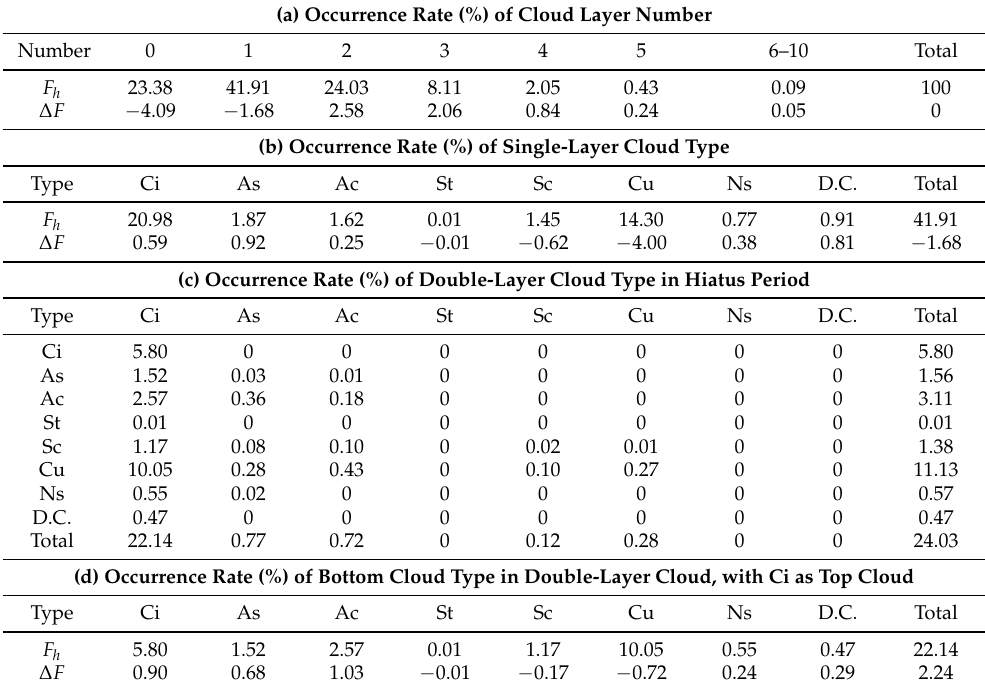
layer clouds were observed most frequently (41.91%), followed by double-layer clouds (24.03%), clear sky (23.38%), and clouds with three or more layers (10.68%). Table 2. Occurrence rate (%) of CVS features.